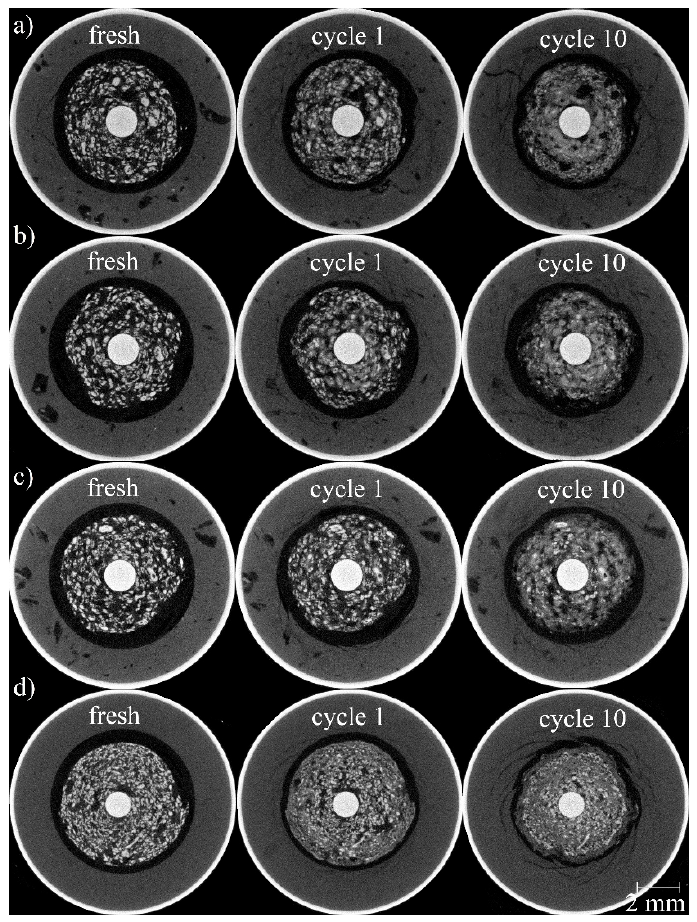
Figure 3. Tomographic cross sections showing three different cycle states for each of the four batteries studied. ( a ) RAM battery discharged at a current of 100 mA, ( b ) 200 mA, ( c ) 400 mA, and ( d ) alkaline manganese primary cell discharged at a current of 200 mA.